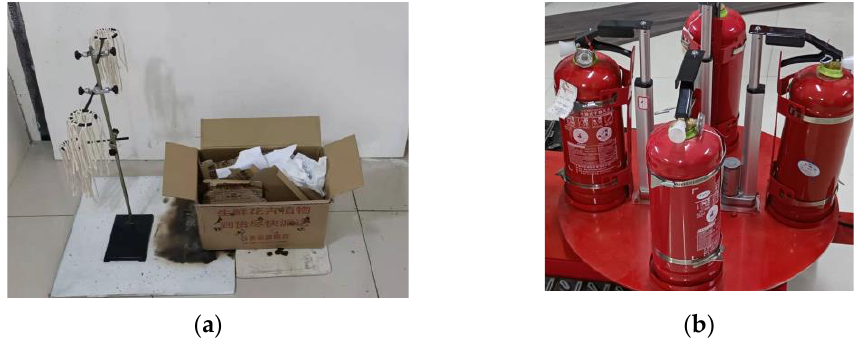
Figure 23. Burning materials and fire extinguishers carried by robot: ( a ) Burning materials. ( b ) The robot carries four 3 kg dry powder fire extinguishers.